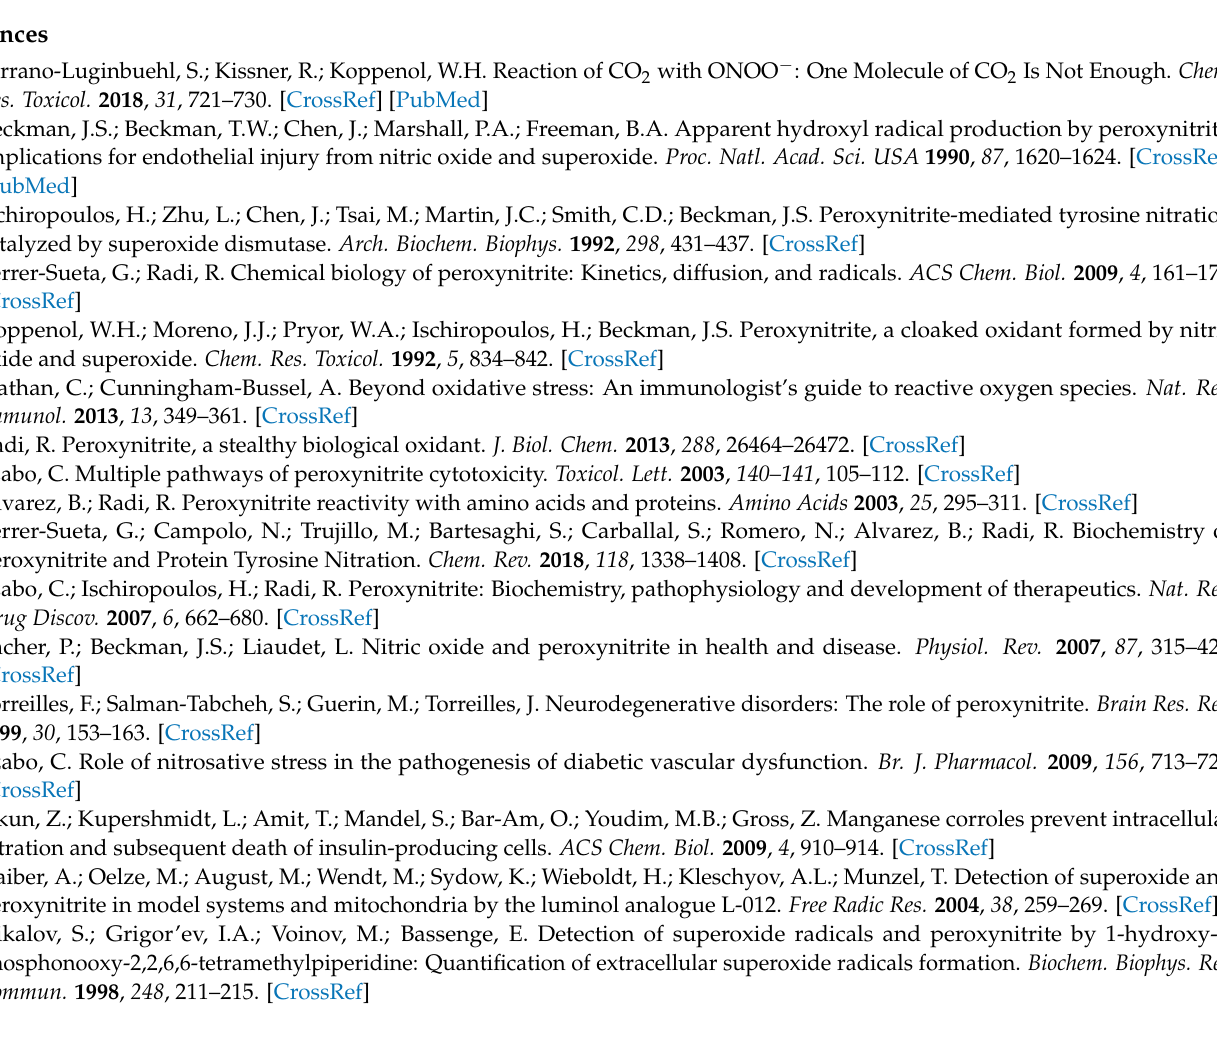
Figure S2: Temporal response kinetics of HDBT-ONOO − and ONOO − ; Figure S3: Cytotoxic assay; Figure S5: 1 H NMR of compound 3; Figure S6: 13 C NMR of compound 3; Figure S7: 1 H NMR of compound 4; Figure S8: 13 C NMR of compound 4; Figure S9: 1 H NMR of HDBT-ONOO − ; Figure S10: 13 C NMR of HDBT-ONOO –; Figure S11:HR-MS of HDBT-ONOO −